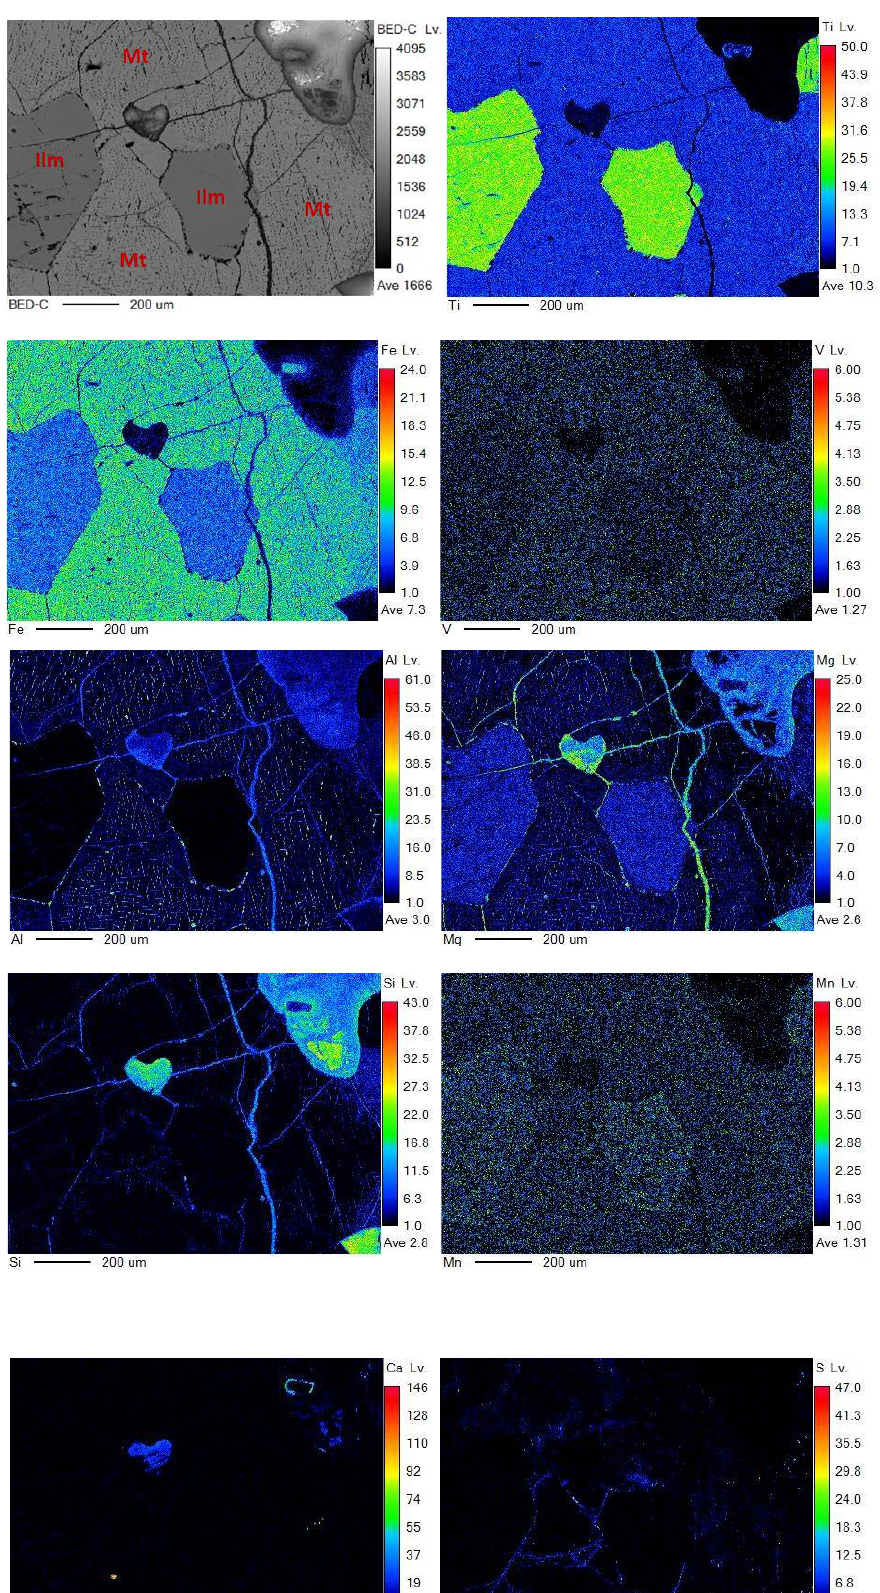
Figure 7. SEM-EDS results for titanomagnetite.